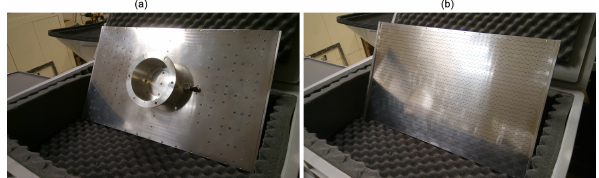
Figure C1. The back (a) and front (b) of the antenna.